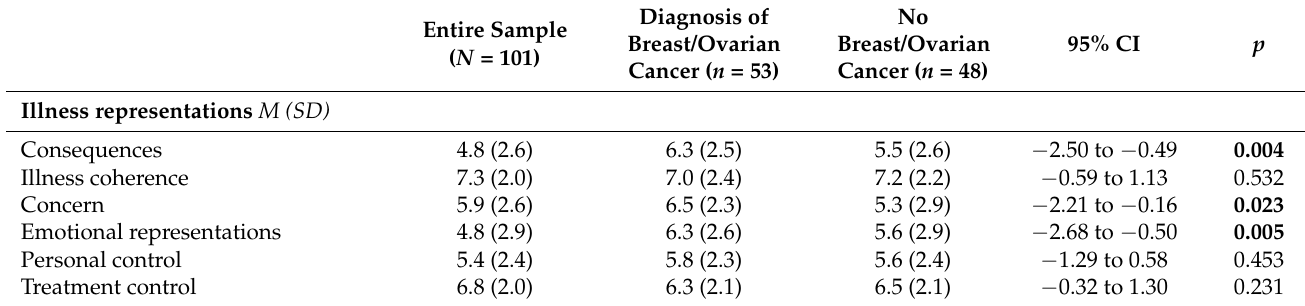
Table 2. Descriptive statistics for dimensions of illness representations, coping strategies, and psychological distress according to breast cancer